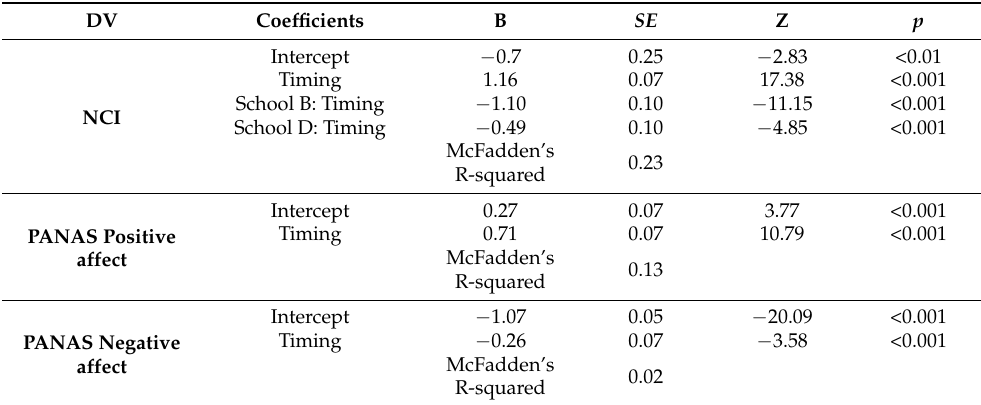
Table 2. Predictors of survey NCI, PANAS positive and negative affect from minimal adequate models after Bonferroni